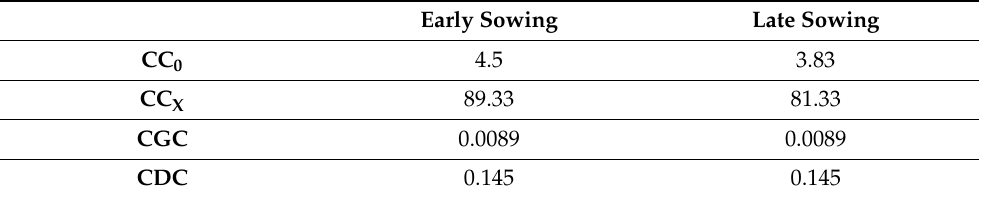
Table 2. Parameters values used to calculate the canopy cover.